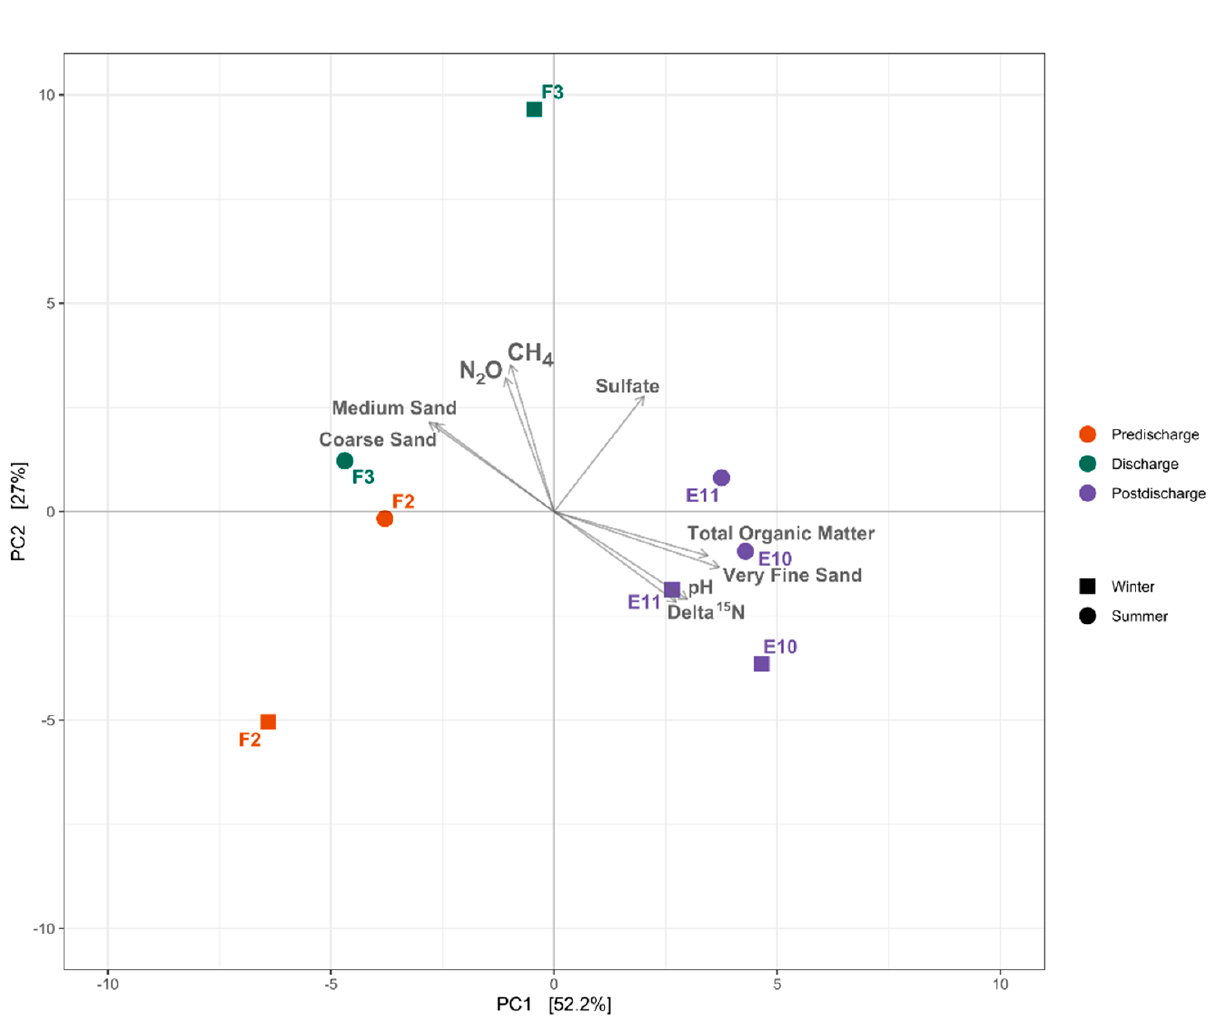
Figure 10. Bray–Curtis based redundancy analysis comparing benthic microbiomes dissimilarities between pre-discharge, discharge, and post-discharge stations and its relationship with physicochem- ical parameters. Parameters significantly correlated with the ordination identified through envfit function p -value < 0.05 were depicted in black.